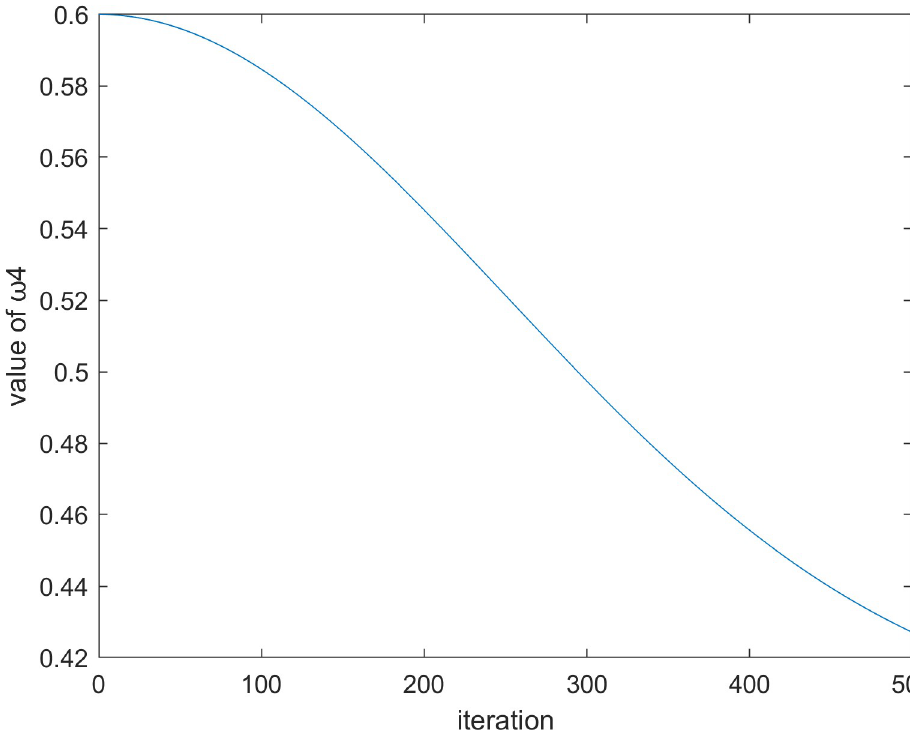
Fig 5. The iteration diagram of ω t